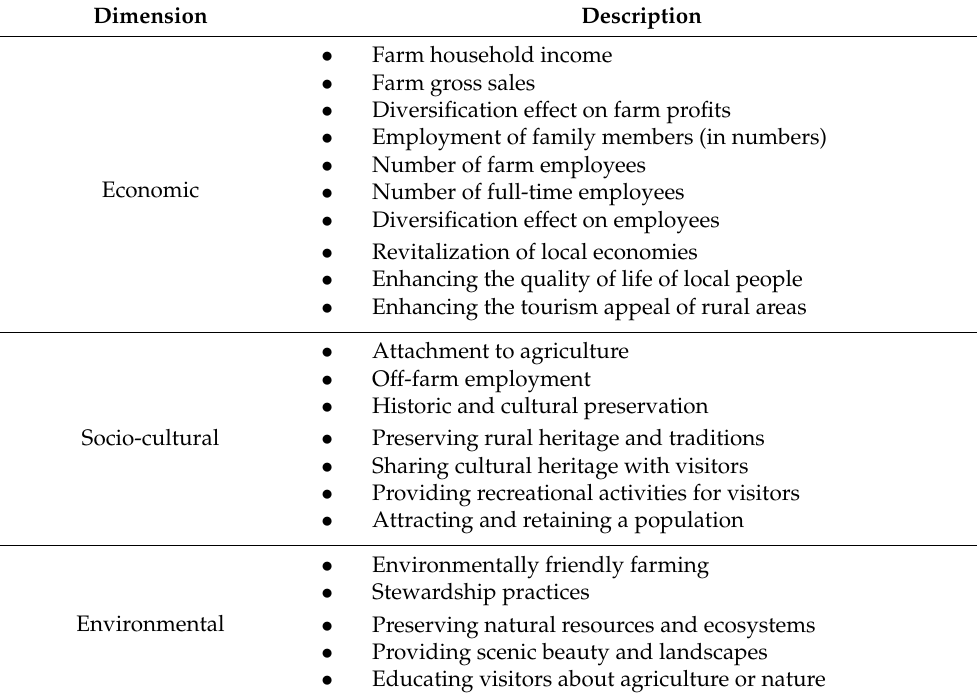
Table 1. Sustainability